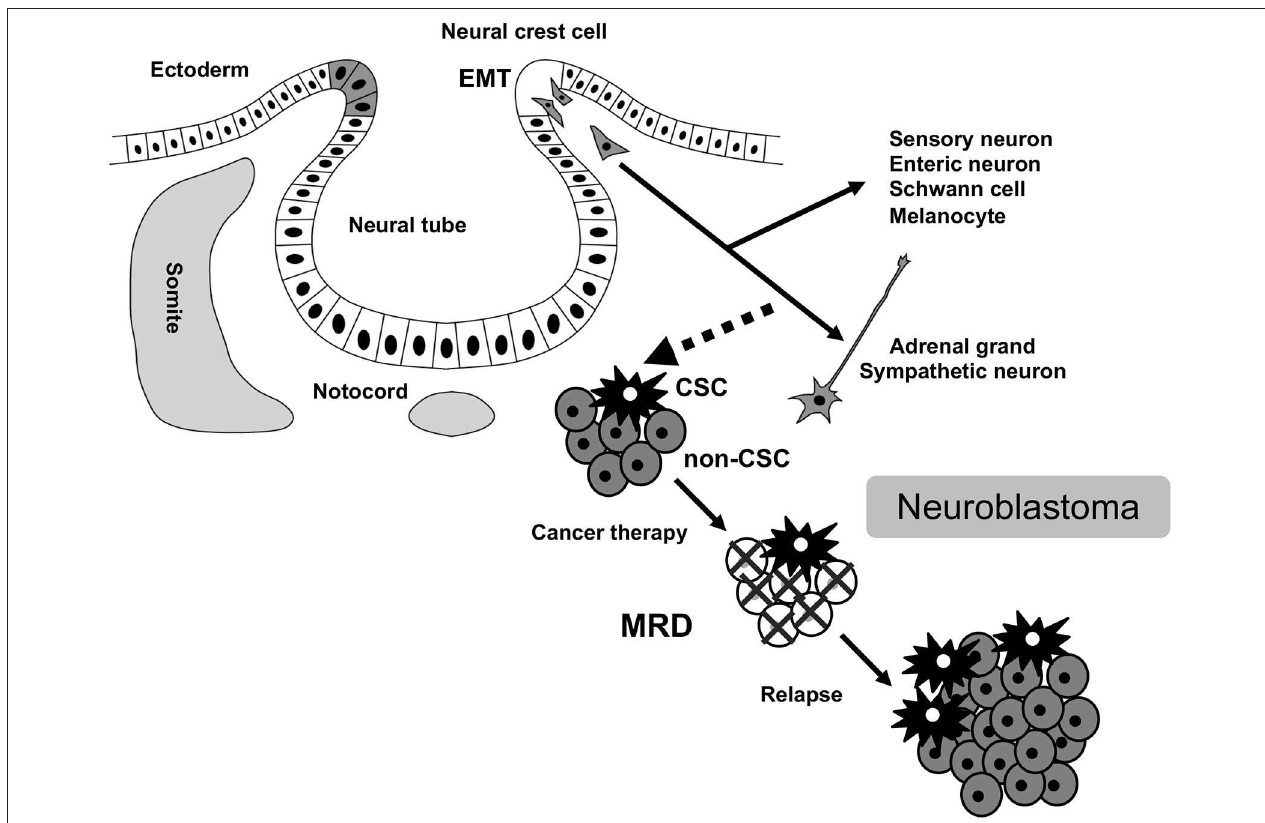
FIGURE 1 | MRD in neuroblastoma. MRD, minimal residual disease; CSC, cancer stem cell; EMT, epithelial-mesenchymal transition.